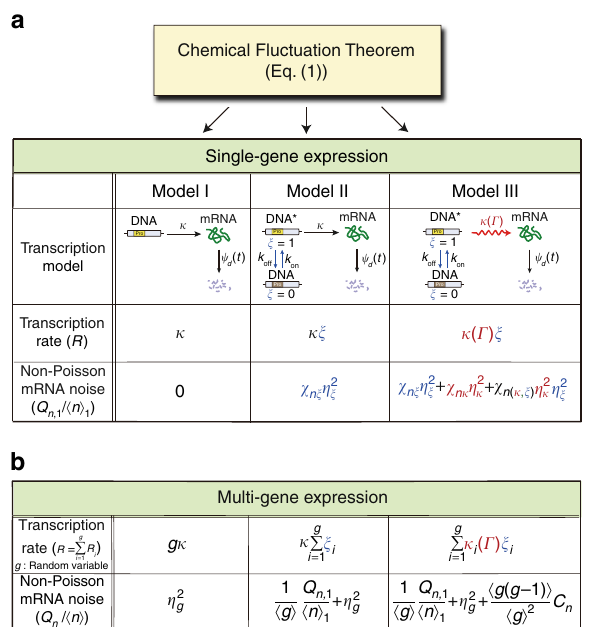
Fig. 1 Chemical Fluctuation Theorem (CFT) applied to various transcription models. Equation (1) relates the variance of mRNA number to the TCF of the transcription rate, whose mathematical form depends on the transcription network model. a In Model I, the transcription rate is given by constant κ . In Model II, the gene state switches stochastically between the active state ( ξ = 1) and the inactive state ( ξ = 0), for which the transcription rate is given by κξ , with κ being a constant and ξ being a stochastic variable. In Model III, the transcription rate is given by κ ð Γ Þ ξ , where κ ð Γ Þ is a stochastic variable dependent on the cell state Γ . For each transcription model, the CFT yields the variance in the mRNA number. Non-Poisson mRNA noise for single- (cid:2) (cid:3) 2 (cid:2) n h i (cid:2) 1 gene transcription is de fi ned by σ n ; 1 = n h i , where σ 2 and h n i 1 1 n ; 1 1 denote the variance and mean of the number of mRNA produced by a single-gene copy, denoted by Q n ; 1 = n h i in the main text ( Q n ; 1 denotes 1 σ 2 = n h i 1). The duration time of each repressed and unrepressed gene 1 (cid:2) n ; 1 state is reported to be an exponentially distributed random variable 36,56 ; the mean is, respectively, denoted by k (cid:2) 1 and k (cid:2) 1 . For mRNA lifetimes, we on off assume an arbitrary distribution, ψ d ð t Þ . The analytic expression of the non- Poisson mRNA noise obtained from Eq. (1) is tabulated for each model (cid:4) (Supplementary Methods). η 2 denotes the relative variance, δ q 2 q